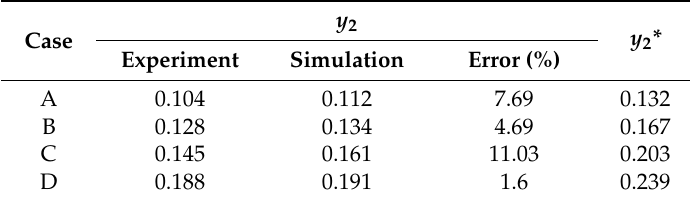
Table 5. Water depths of Cases A–D after hydraulic